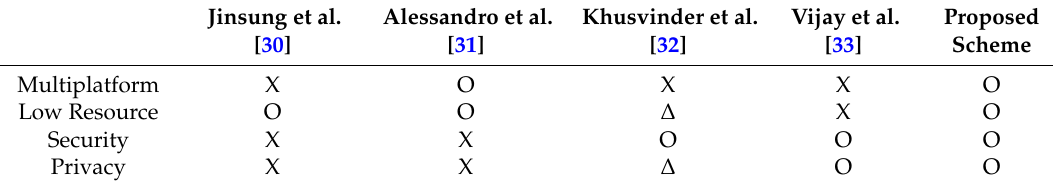
Table 2. Comparative security analysis between smart home